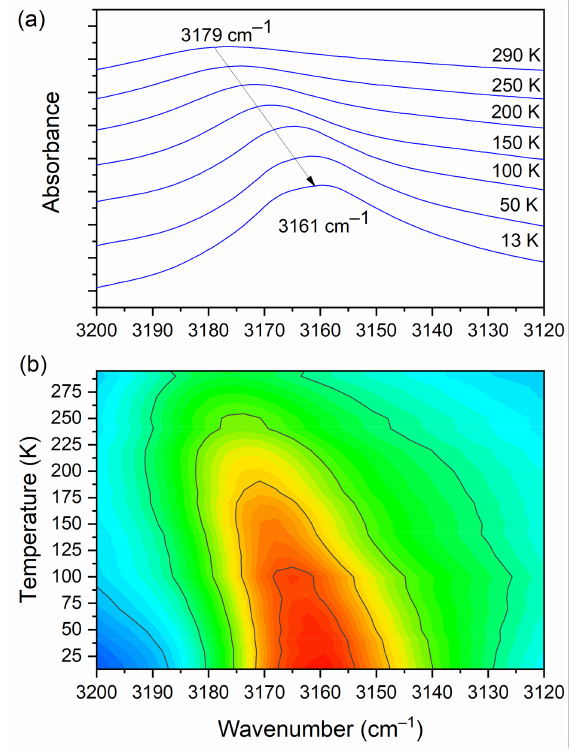
Figure 12. ( a ) IR spectra in the wavenumber range of 3200–3120 cm − 1 during cooling of the N,N- dimethylglycine–chloranilic acid co-crystal; ( b ) contour plots of IR spectra in the H-bonding region (O–H vibration from CLA